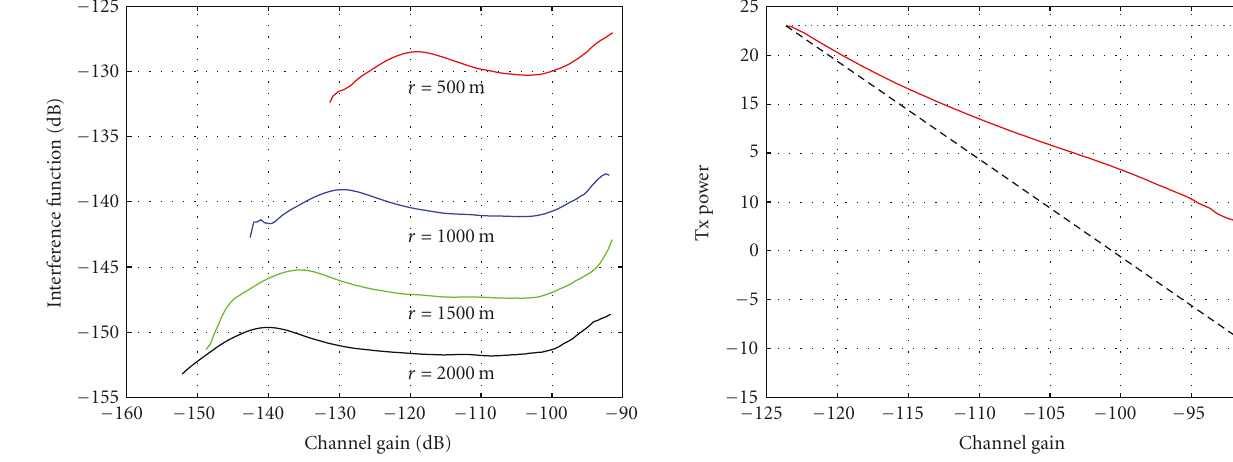
Figure 3: Interference functions for di ff erent cell radiuses.